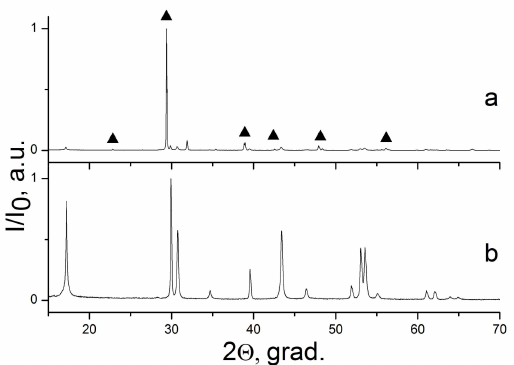
Figure 1. X-ray diffraction patterns of NaYF 4 sample 3 before ( a ) and after ( b ) washing with water. NaNO 3 phase lines are marked with triangle